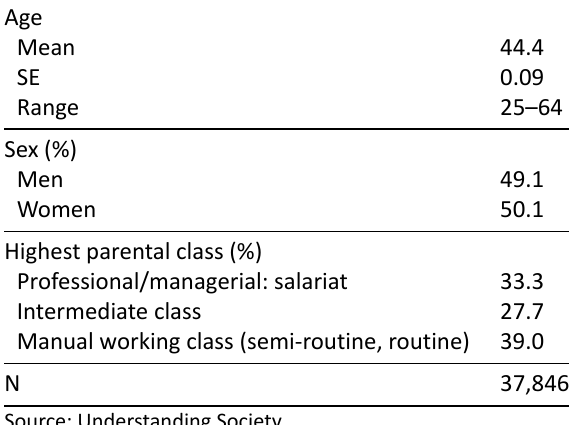
Table 2. Main control variables and their distribution in the